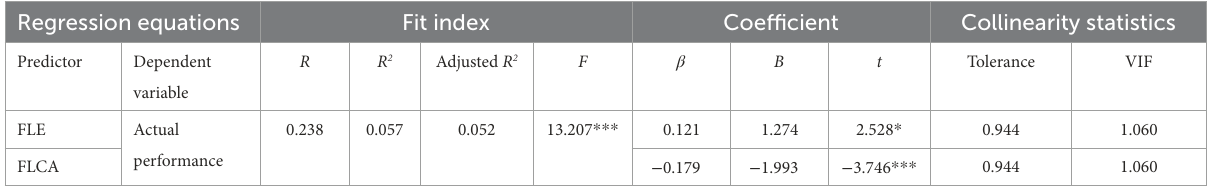
TABLE 6 Regression analysis with three emotions as predictors of actual performance for reading-and-writing group. Regression